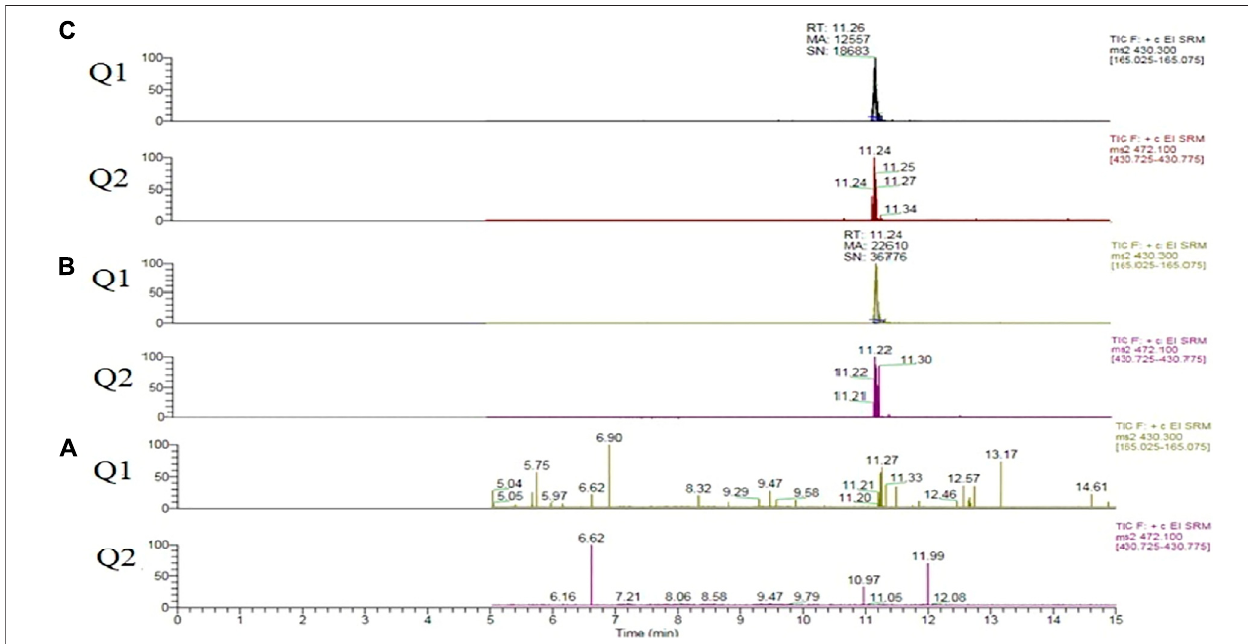
FIGURE1| VitaminEacetateextractedquanti fi er(Q1)andquali fi er(Q2)iontransitions. (A) Sample202. (B) Forti fi edsample202 at2.5 µg/mLofvitaminEacetate. (C) Pure vitamin E acetate diluted in methanol at 2.5 µg/mL (no matrix present).